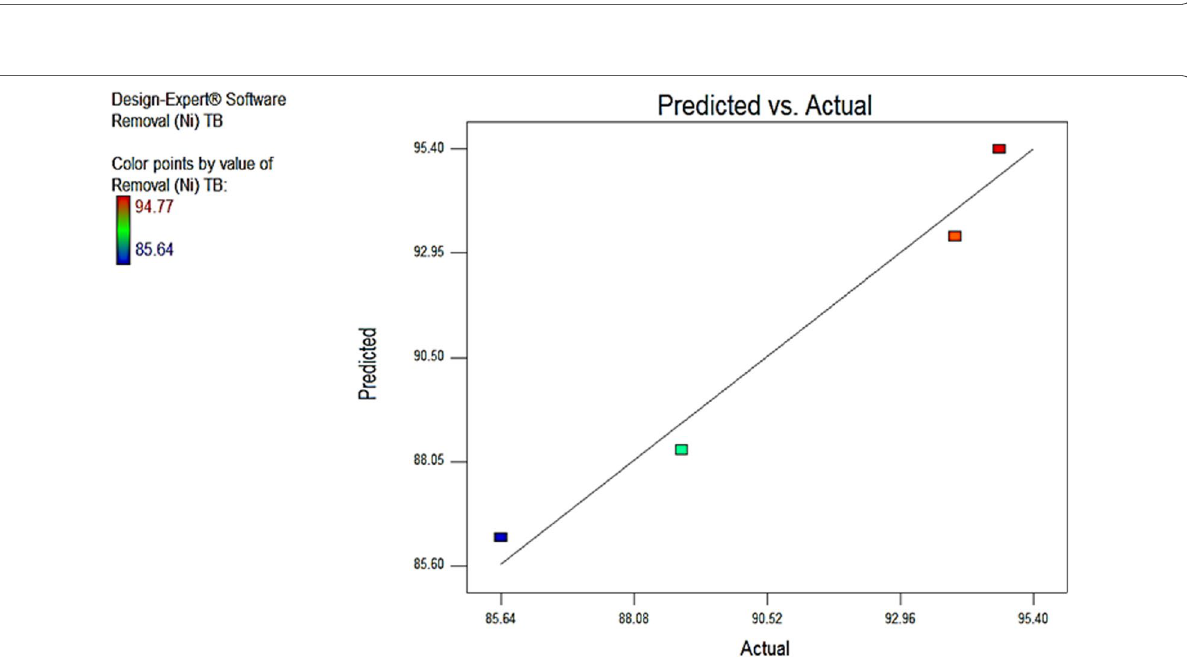
Fig. 9 A cross-validation plot predicted response against actual values of response from selected factorial model on the removal of Nickel when tea bag residues are used as